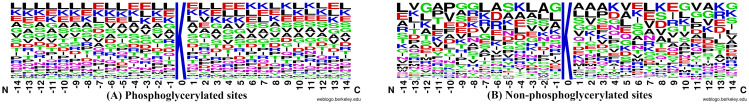
Amino acid frequencies around the K-PTM and non-K-PTM sites.